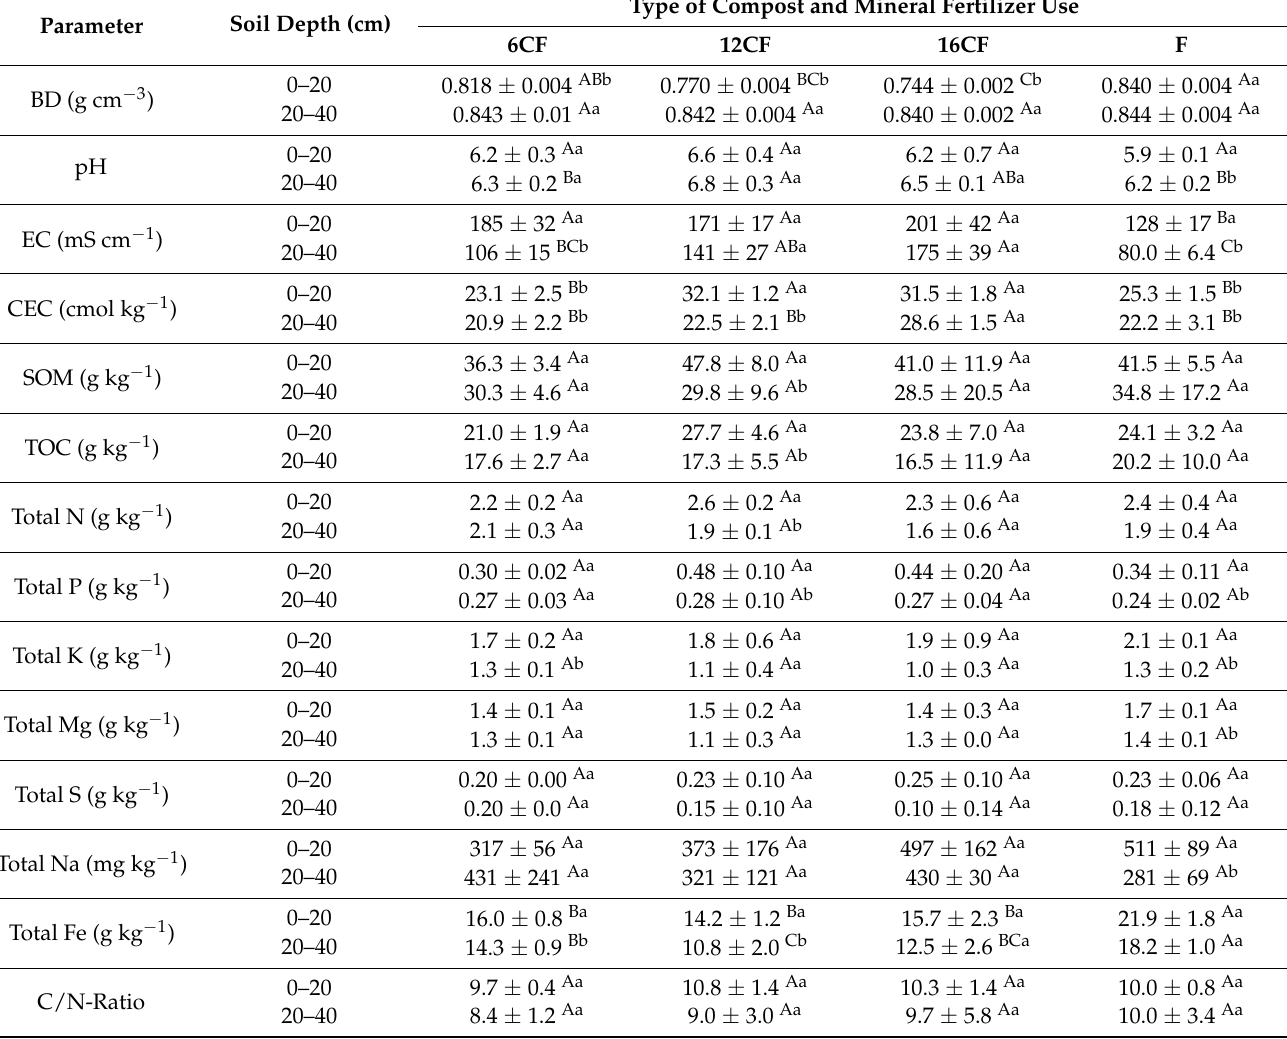
Table 2. Soil physical and chemical properties in 0–20 and 20–40 cm soil depths of smallholder farmers’ fields applied with different rates of compost and mineral fertilizer (n = 4, mean ±